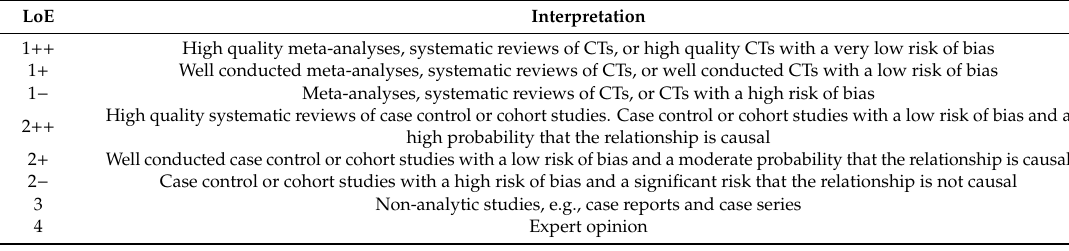
Figure 1. Flow diagram following the PRISMA methodology that reflects the selection and evaluation process of the analysed papers. Table 1. Level of Evidence (LoE) assigned to each article according to its quality.